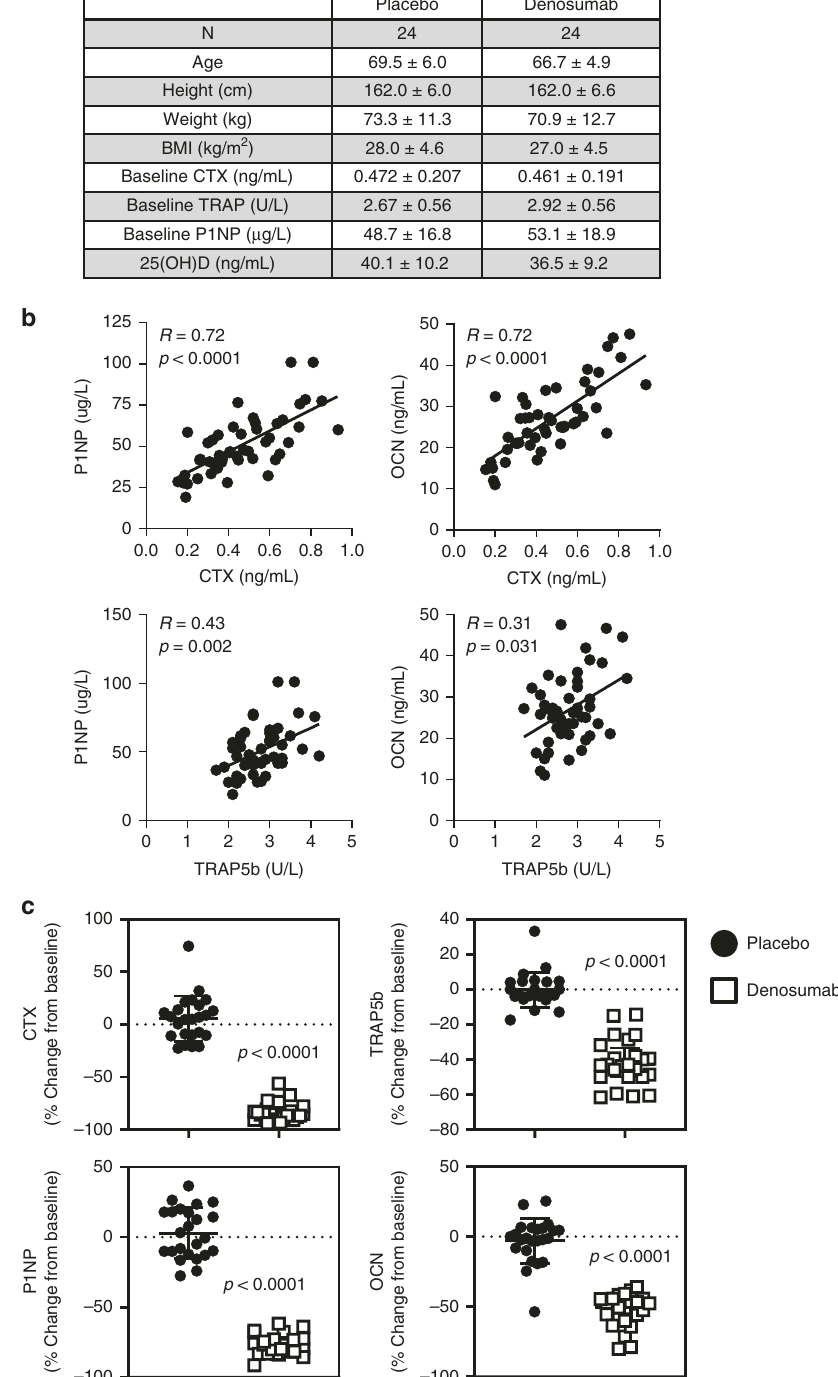
Fig. 1 Baseline participant characteristics and effects of DMAb on bone metabolism. a Baseline clinical and biochemical data in the study participants. b Correlations at baseline between markers of bone formation (PINP, μ g/L; OCN, ng/mL) and resorption (CTX, ng/mL; TRAP5b, U/L) demonstrating coupling of bone formation and resorption at the systemic level ( N = 48 participants); Spearman ’ s correlation coef fi cient was used to determine strength of relationships. c Changes in markers of bone resorption (top panels) and bone formation (bottom panels) over 3 months (% change from baseline, N = 24 participants per group). Individual values are plotted with mean and error bars represent SD. Signi fi cance was determined using the Mann – Whitney test. Source data are provided as a Source Data fi